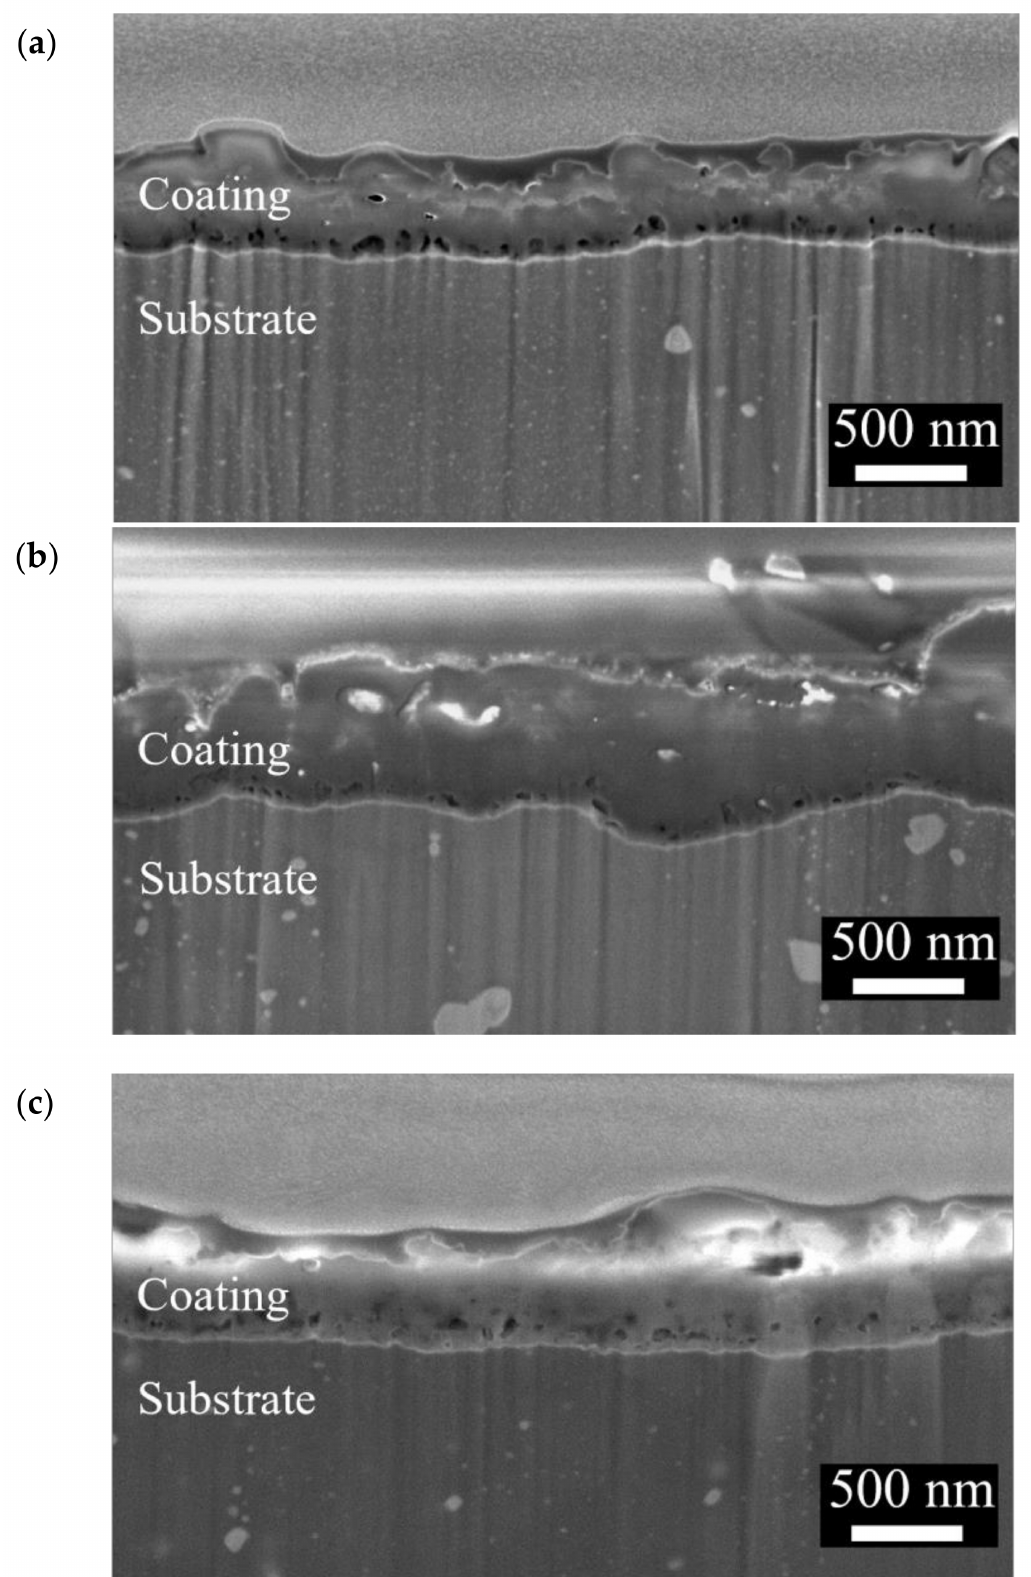
Figure 3. Cross-section morphologies of the anodic coatings prepared at 250 V for ( a ) 5 min, ( b ) 10 min, and ( c ) 25